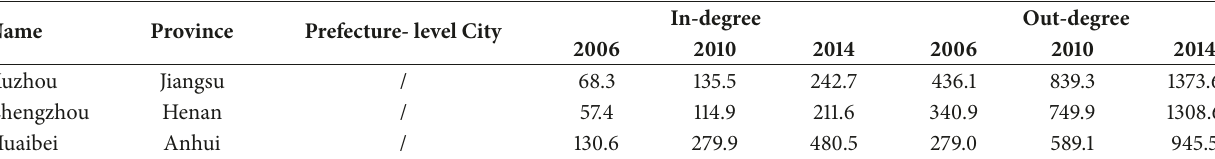
Table 3: Statistical table of Huaihe Basin’s top three out-degree cities.